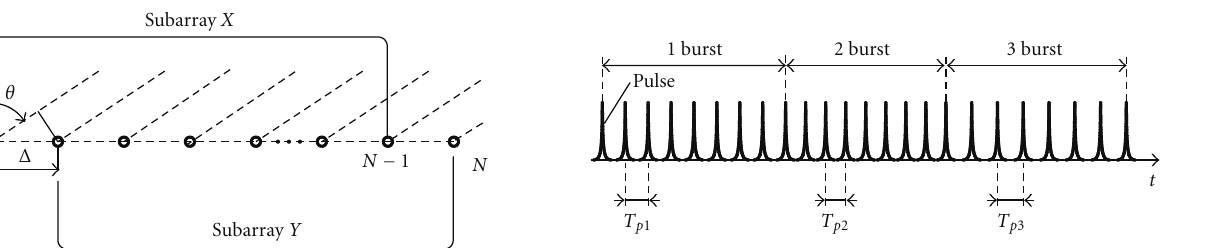
Figure 1: A uniform linear array antenna composed of N sensors and their ( N − 1)-sensor subarrays X and Y .